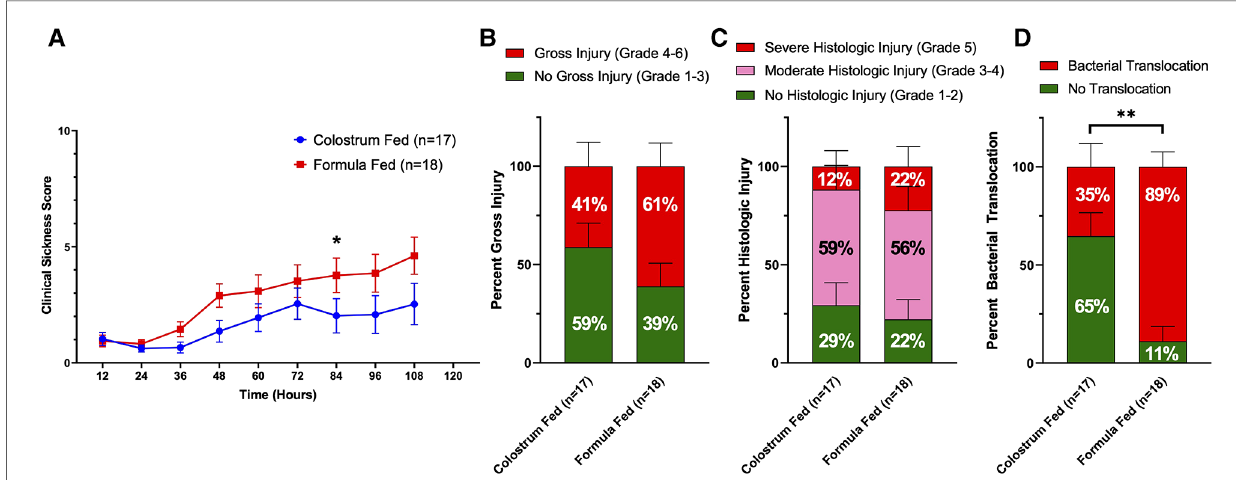
FIGURE 3 Components of D-NEC score. ( A ) Clinical Sickness Scores (CSS). Each data point represents the average CSS for all piglets in that group. If a piglet was euthanized prior to the end of the experiment, that piglet was given a score of an 8 for all remaining time points of the experiment; ( B ) Gross Injury Scores; ( C ) Histologic Injury Scores; ( D ) Bacterial Translocation. Variability of sample means was reported as a standard error of the mean (SEM) and statistical signi fi cance level was set to α =0.05. Statistical analyses for gross injury score, histologic injury score, and bacterial translocation were carried out